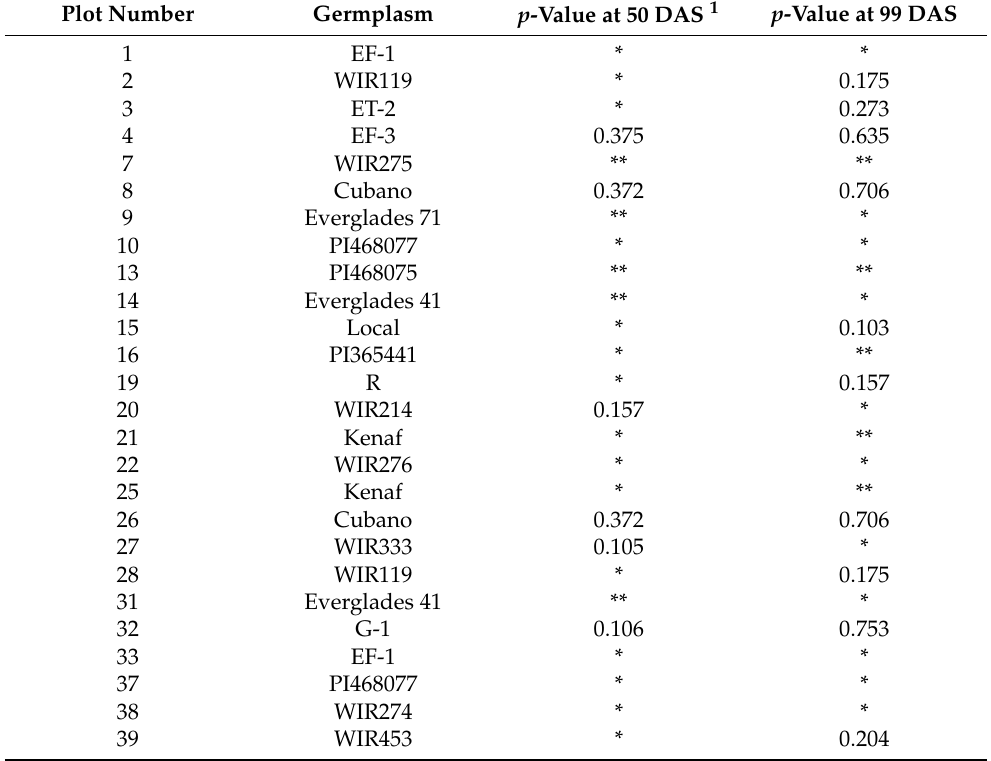
Table 2. The results of Kruskal–Wallis test among the replications. All plots in this table are in the low-growth region (blue dot polygon in Figure